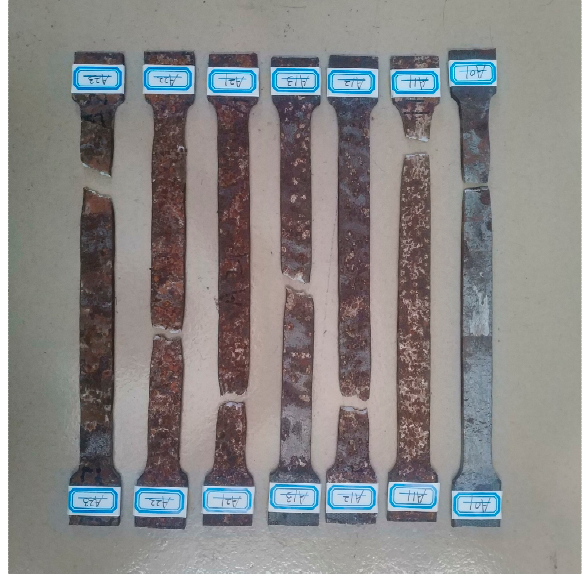
Figure 8. Failure mode of the tensile specimens. Table 3. Mechanical property indices of the specimens. Specimen